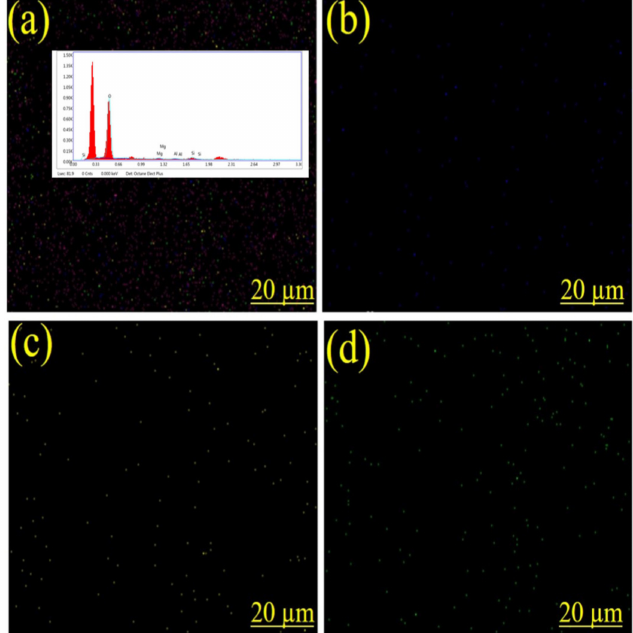
Figure 7. SEM-EDS elemental mapping images of PLA / CTAC-MMT nanocomposites; ( a ) O, Mg, Al, and Si mapping, ( b ) Mg mapping, ( c ) Al mapping ( d ) Si